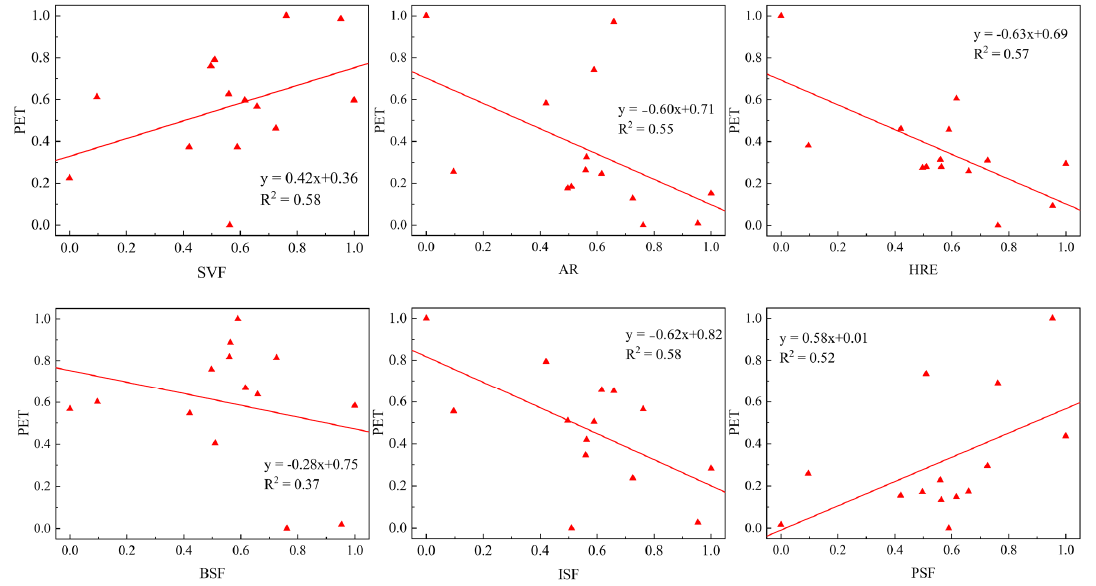
Figure 12. Linear fitting results of normalized spatial morphology parameters and PET.